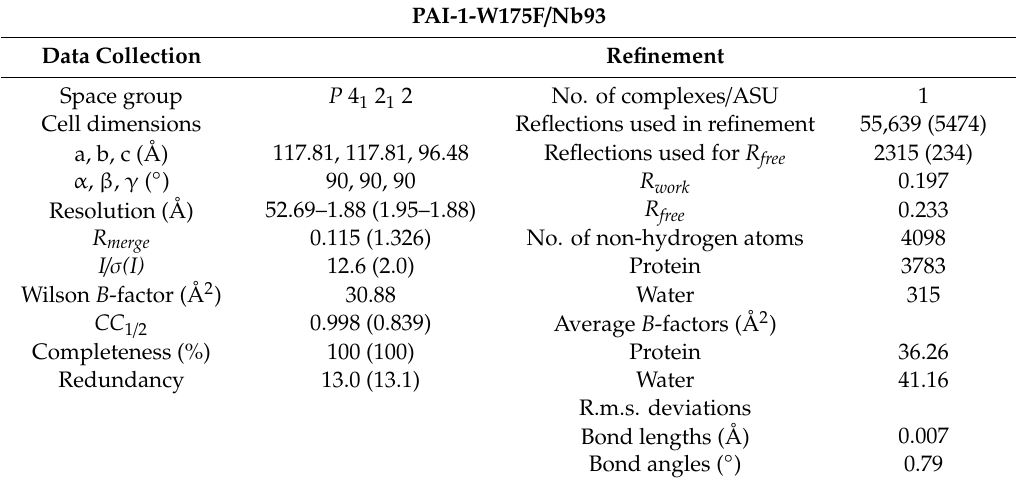
Table 1. Data collection and refinement